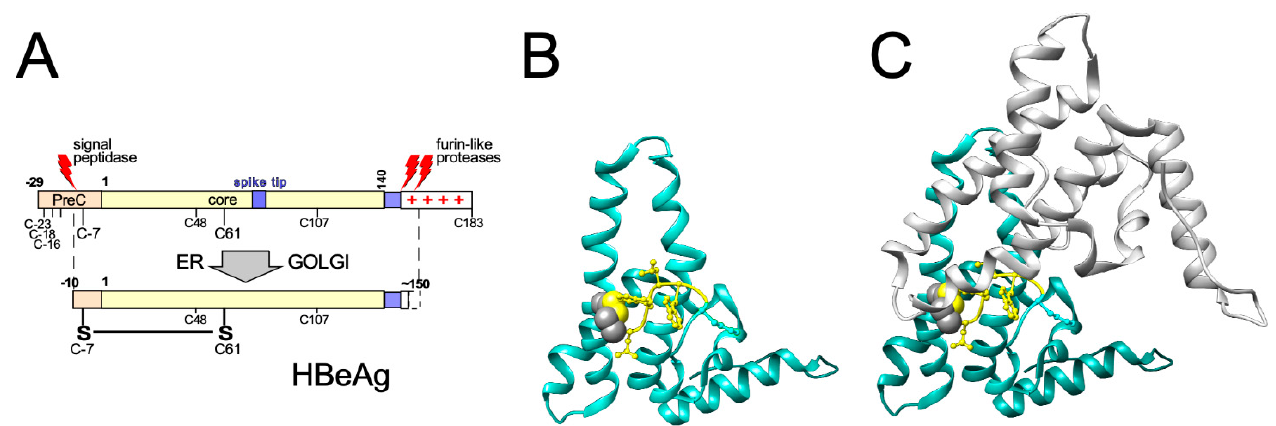
Figure 5. HBeAg, a distinct structure despite nearly identical primary sequence to the Cp assembly domain. ( A ) Processing pathway of the precore protein. Cotranslation of the 29 codons of the preC region with the core ORF generates the precore protein. The first 19 PreC aa act as signal peptide directing the protein into the ER where N terminal cleavage occurs; during transit through the secretory pathway furin-like proteases clip-off most of the basic CTD, and in the oxidizing environment a specific disulfide bridge is formed between C-7 and C61 which determines the distinct structure of HBeAg. Failed signal peptide cleavage can create an only C terminally processed recently termed PreC protein (not shown) that contributes serologically to the “hepatitis B core-related antigen” (HBcrAg). ( B ) Crystal structure of one monomer in the HBeAg dimer (PDB 3V6Z). The preC-derived extra sequence is shown in yellow; C-7 and C61 are depicted as spheres. The second monomer is omitted for clarity. ( C ) The HBeAg dimer. The second monomer is shown in grey. Note the completely different dimerization mode compared to Cp which creates new epitopes, exposes epitopes that are hidden in the assembled capsid, and prevents HBeAg multimerization.